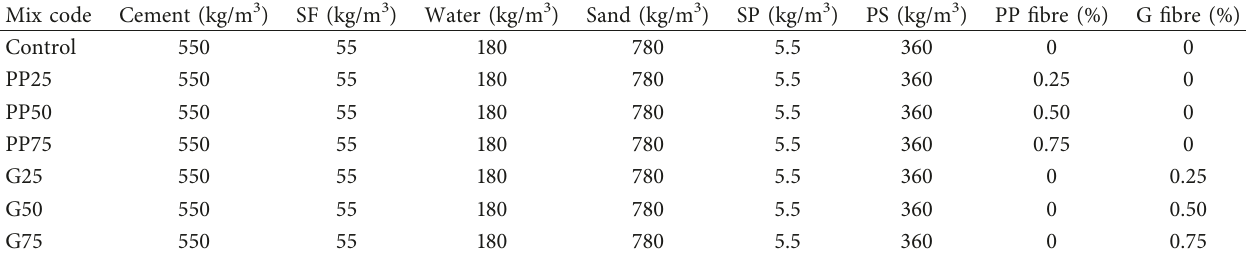
Table 3: Mix proportion of concretes.